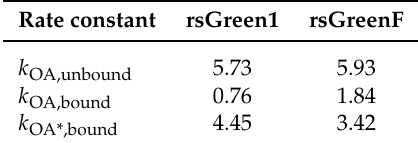
Table A4. The effect of molecular brightness and photoswitching on model parameters